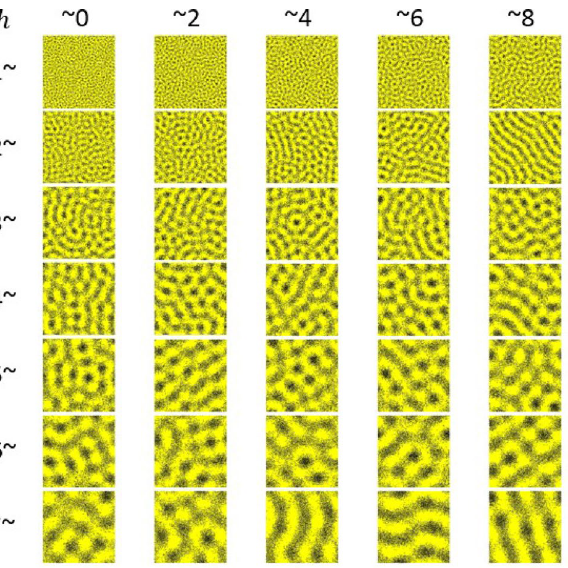
Figure 4. Stationary Turing patterns with varying h values in Monte Carlo simulations of the Survival model. Each simulation was performed on a 400 × 400 static lattice with periodic boundary conditions. The following parameters were held constant: b M = 7 , d M = 9 , b X = s = 1 , d X = d MX = 0 . For each pattern shown, the first digit of the h value is given by the row label and the second digit is given by the column label. For example, the Turing pattern in the fifth row and third column has h = 54